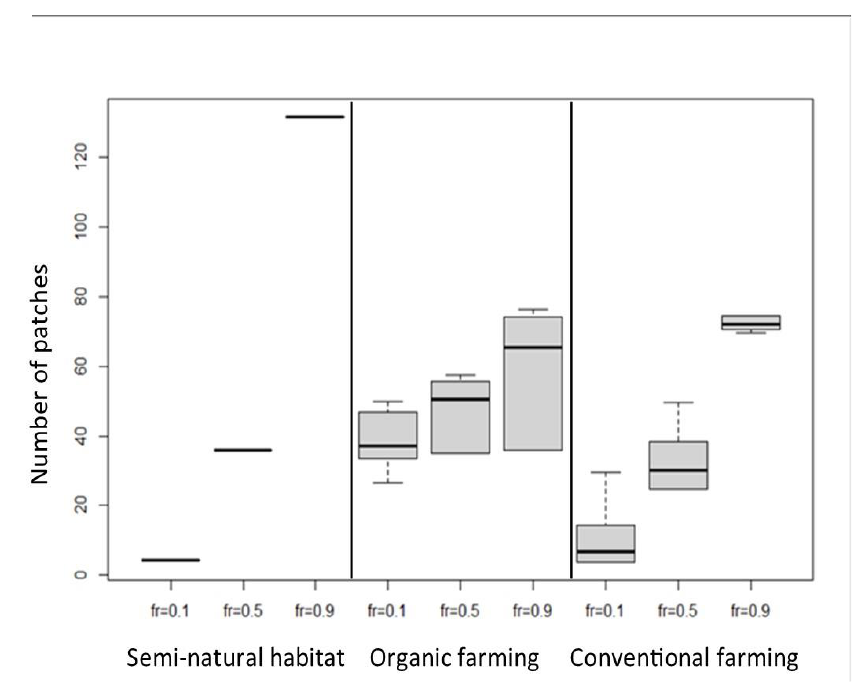
Figure S1.1 : Number of patches per landscape and habitat type for the three levels of semi-natural habitat fragmentation fr. The graph presents box plots of all values pooled over the 11664 landscapes at the end of simulations of OF expansion (t=50) The dark line is the median, whiskers represent the first and third